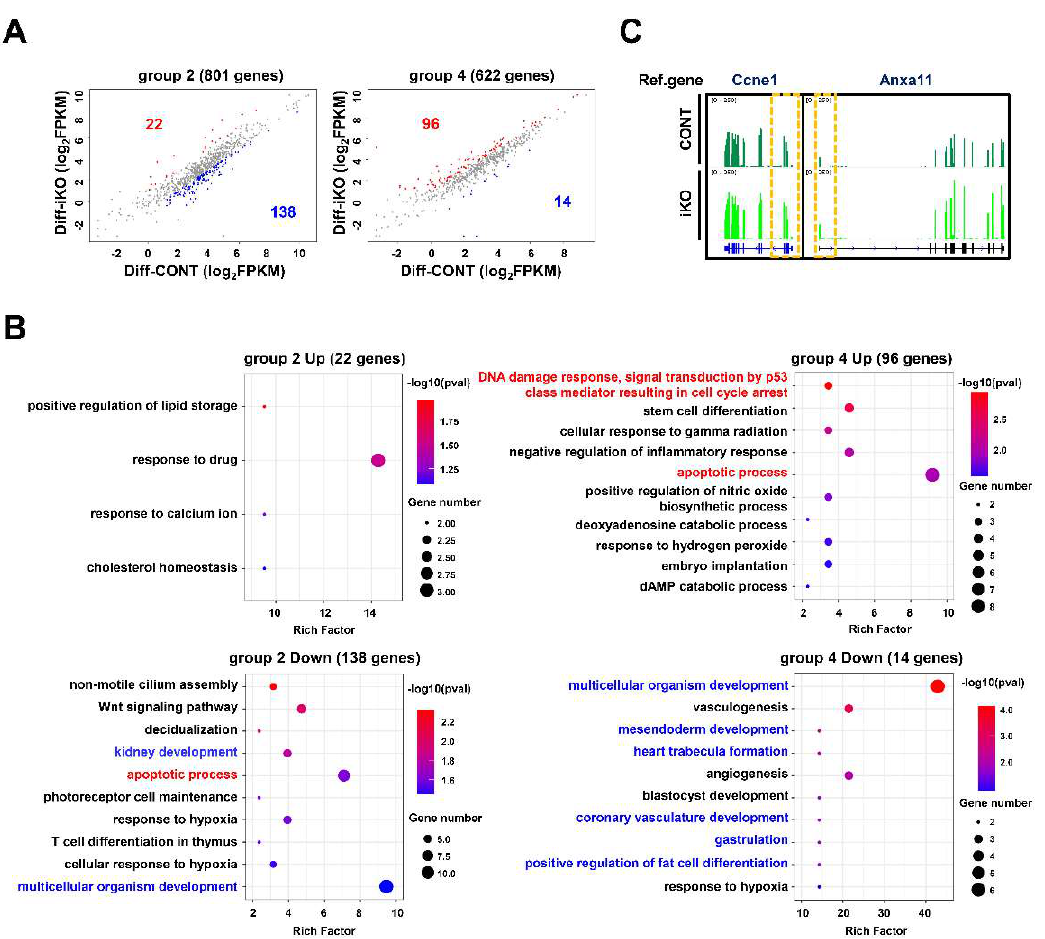
Figure 5. Cell cycle- and apoptosis-related genes in differentiating ESCs. ( A ) Scatter plots showing selected DEGs (that are contained in group 2 and 4 in Figure 2A) in the Diff–iKO ESCs. ( B ) Bubble plots showing GO terms with group 2 or 4 DEGs that are common up-regulated or down-regulated genes in Diff–iKO ESCs. Terms associated with cell cycle or apoptosis are highlighted with red fonts, and terms associated with development are highlighted with blue fonts. ( C ) Visualization of representative DEGs (Ccne1 and Anxa11) associated with G1/S transition using